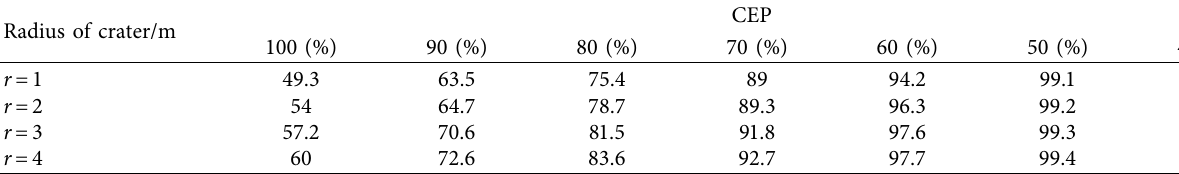
Table 8: Influence of the CEP and crater size of subprojectiles on the blockage probability.